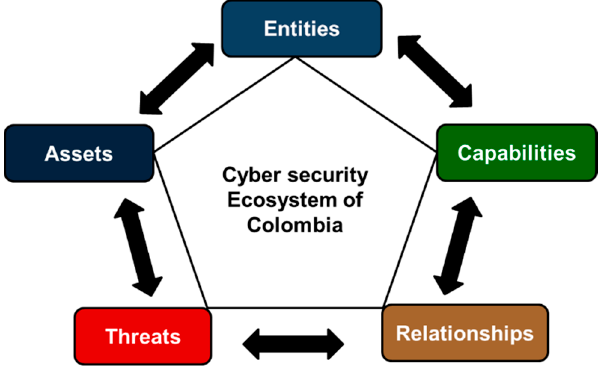
Figure 1. Components of the Cyber security Ecosystem of Colombia.